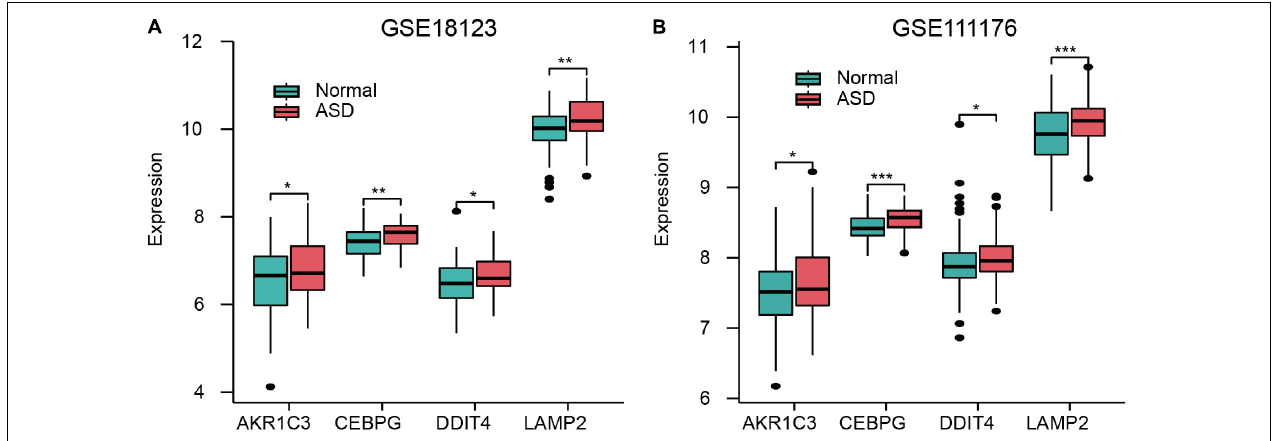
FIGURE 4 | Expression of FRGs in GSE18123 (A) and GSE111176 (B) . * p < 0.05, ** p < 0.01, *** p < 0.001.